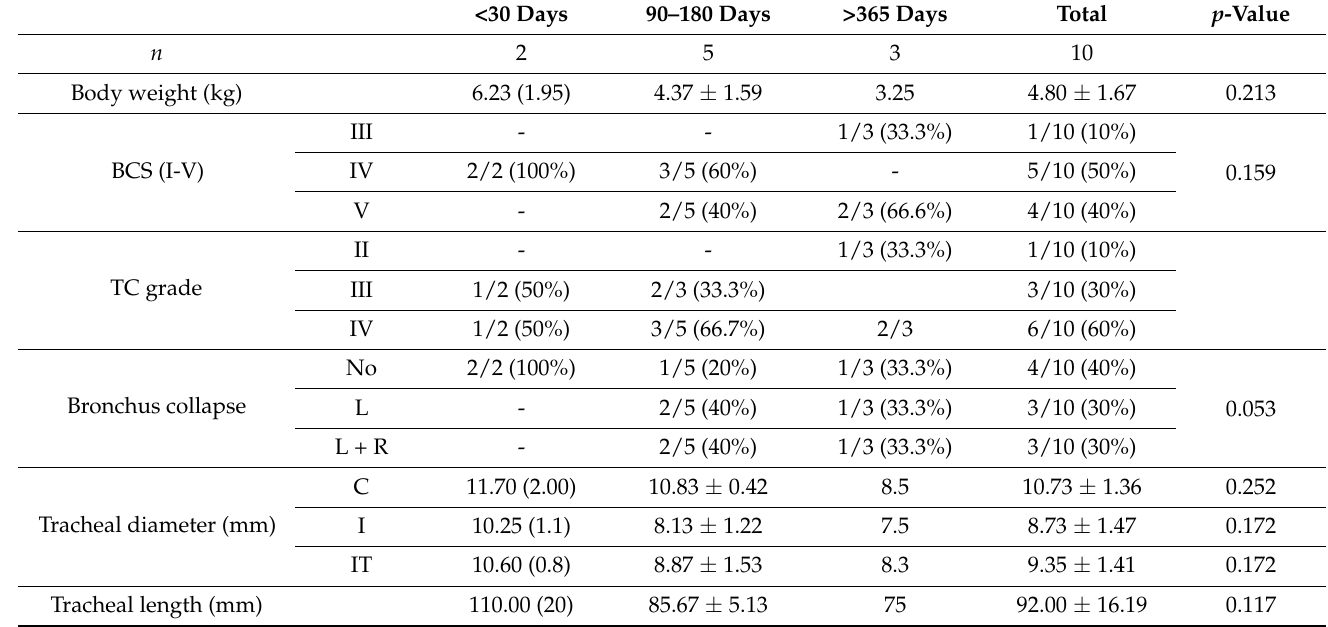
Table 1. Characteristics of the patients. General data recorded. Body condition score (BCS). Data are presented as the mean and standard deviation (SD) for normally distributed variables. Data are presented as the median and range for non-normally distributed